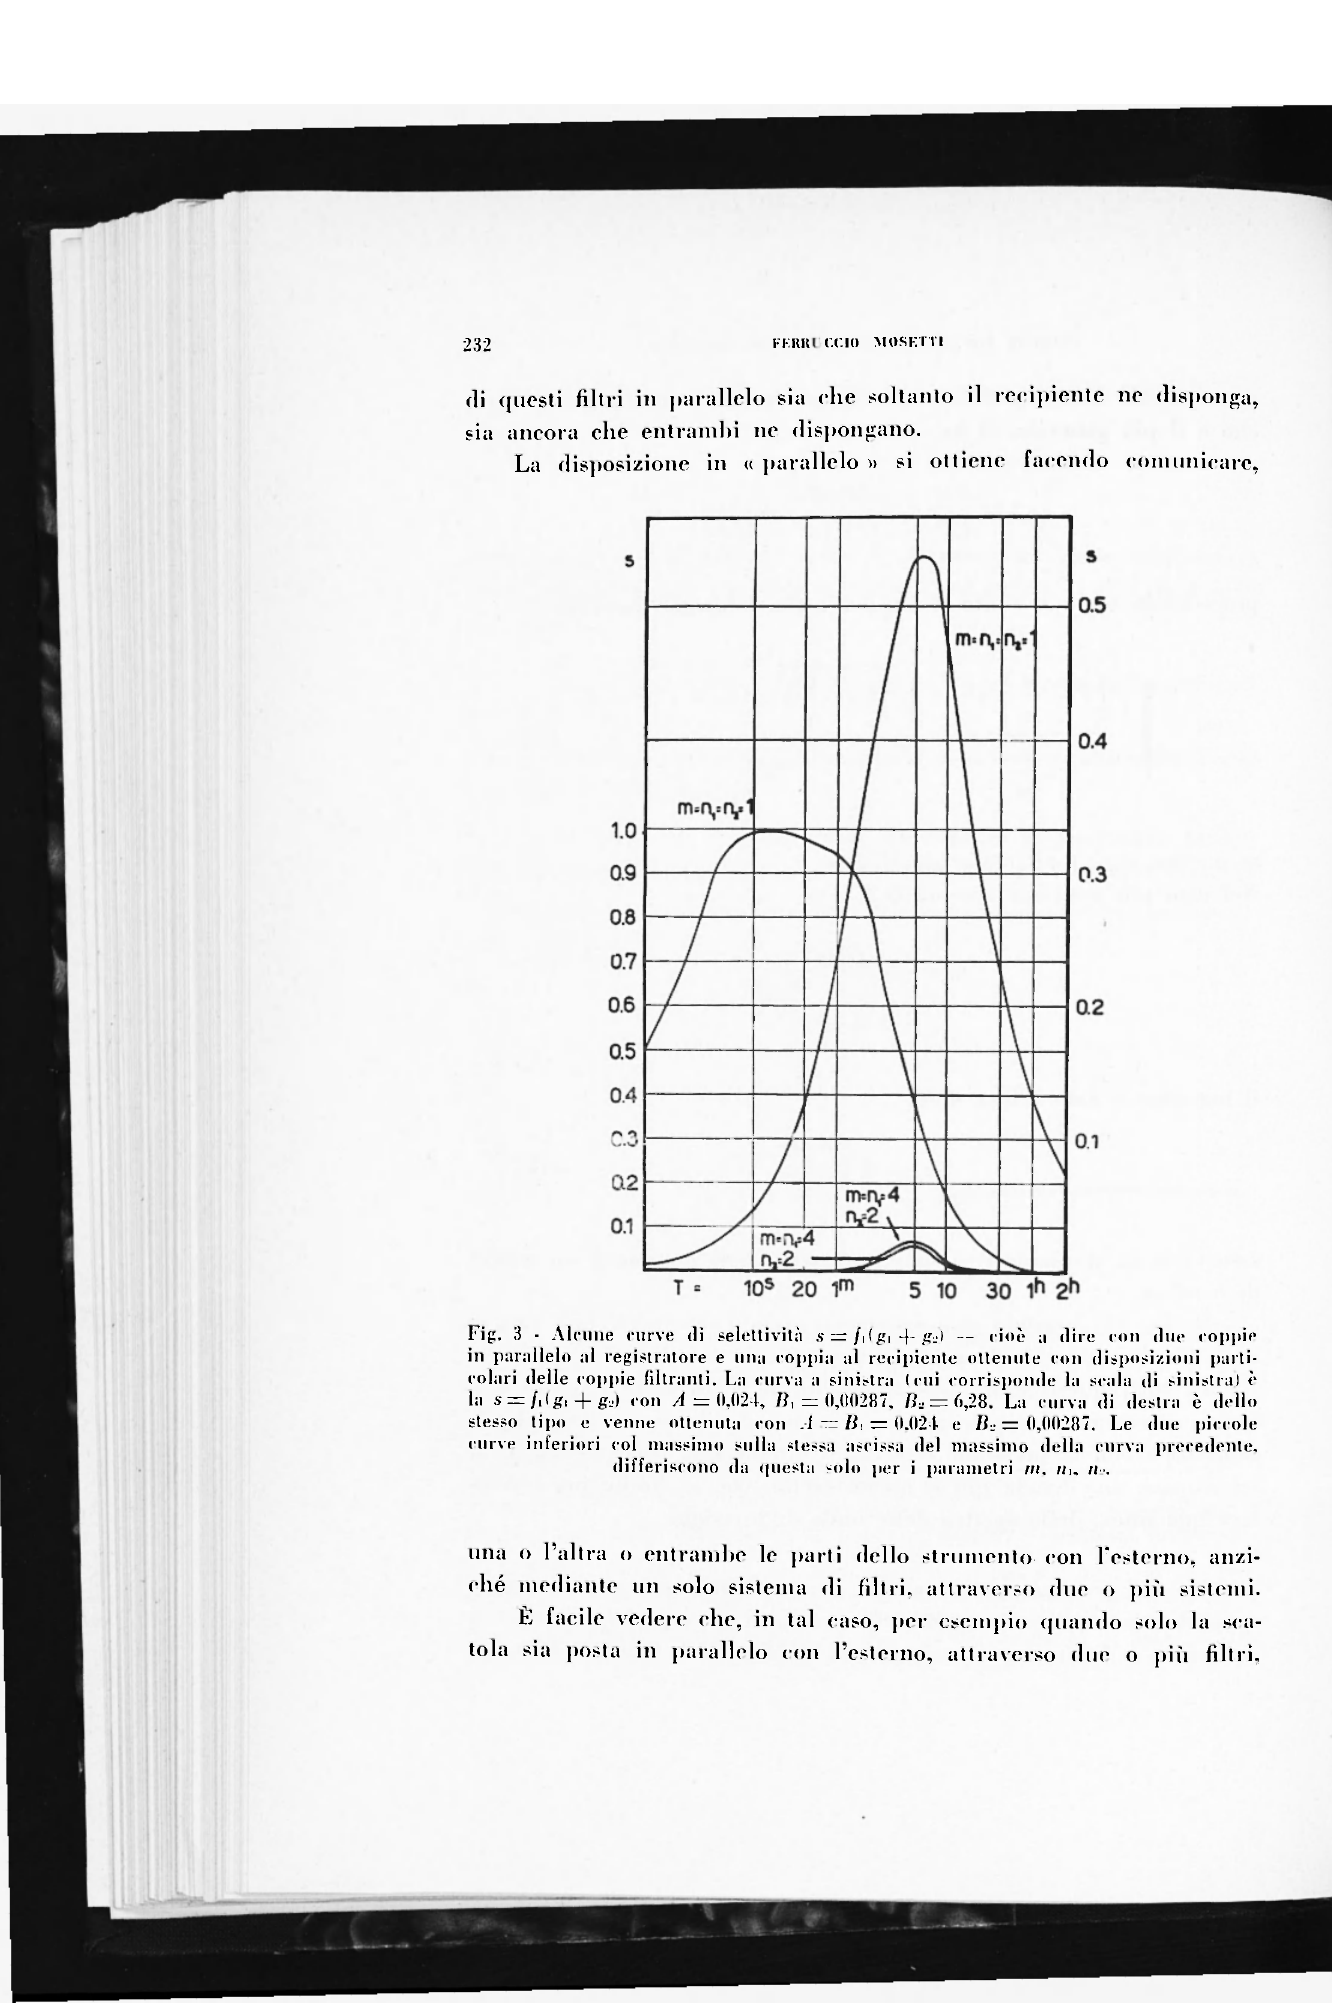
Fig. 3 - Alcune curve di selettività s = /i(gì + — cioè :i dire con due coppie in parallelo al registratore e una coppia al recipiente ottenute con disposizioni parti- colari delle coppie filtranti. La curva a sinistra (cui corrisponde la scala di sinistra) è la s =/,(g, + g,| con A = 0,024, B, = 0,00287, fi,. = 6,28. La curva di destra è dello stesso tipo e venne ottenuta con A = B, = 0,024 e B? = 0,00287. Le due piccole curve inferiori col massimo sulla stessa ascissa del massimo della curva precedente, differiscono da questa solo per i parametri in, n,. n